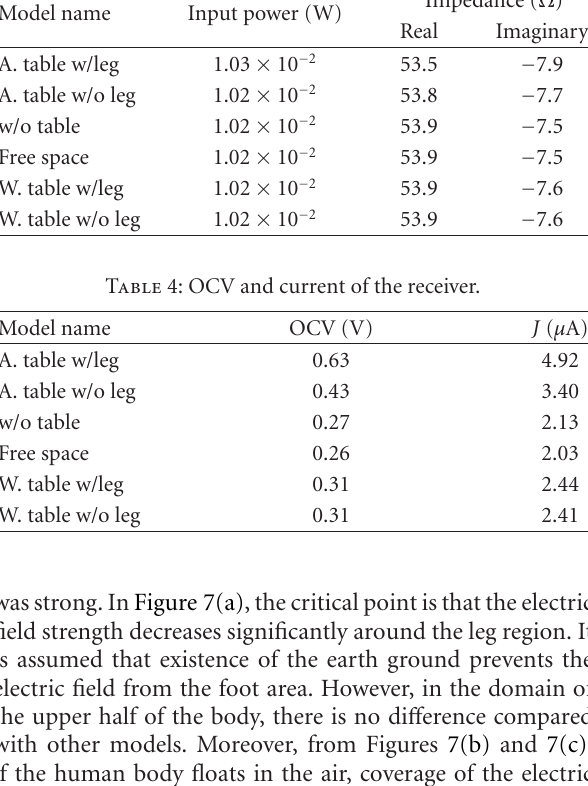
Figure 7: Electric field distribution around the human body.